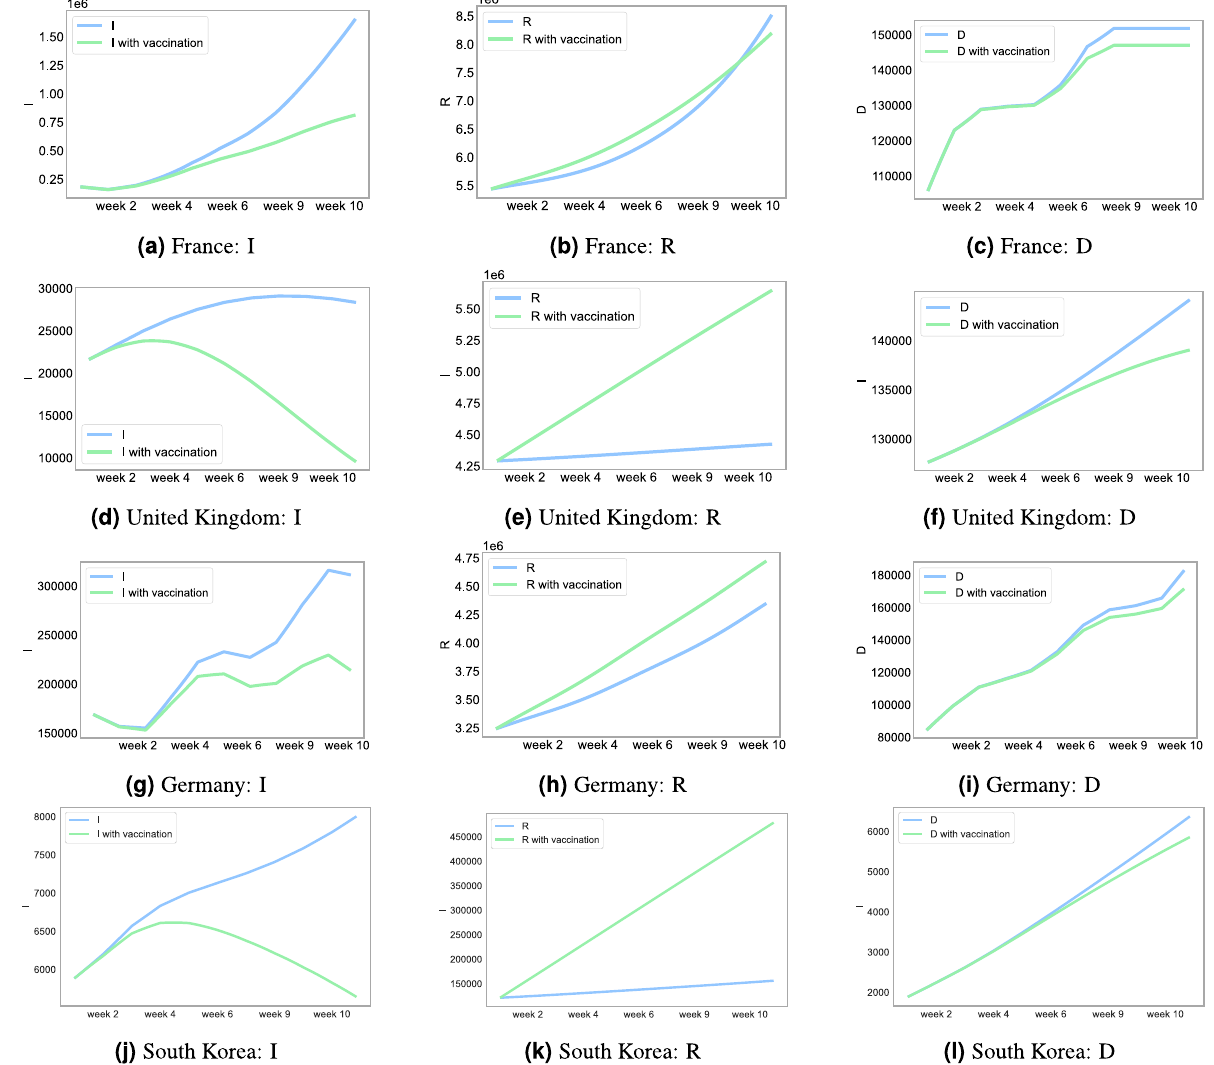
Figure 6. The SIRD prediction with the LSTM network for France, United Kingdom, Germany, and South Korea. The plots display I, R, and D prediction against the time (Days) for 10